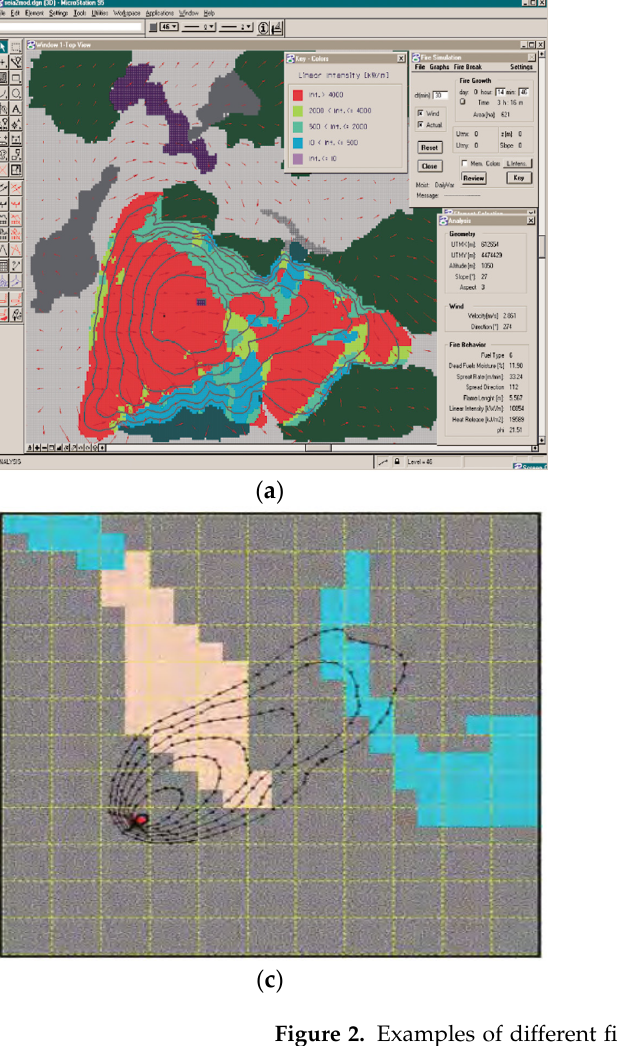
Table 2. The input parameters considered by fire simulation software.